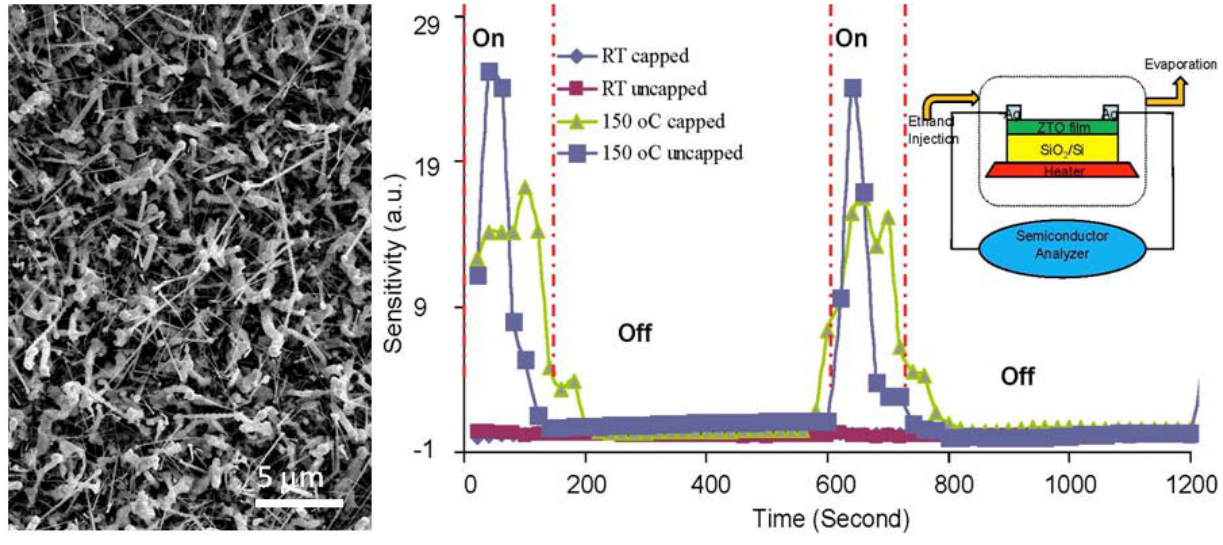
Figure 15. SEM image of top view Zn the time dependence sensitivity spectra of ZTO nanowire devices in both open